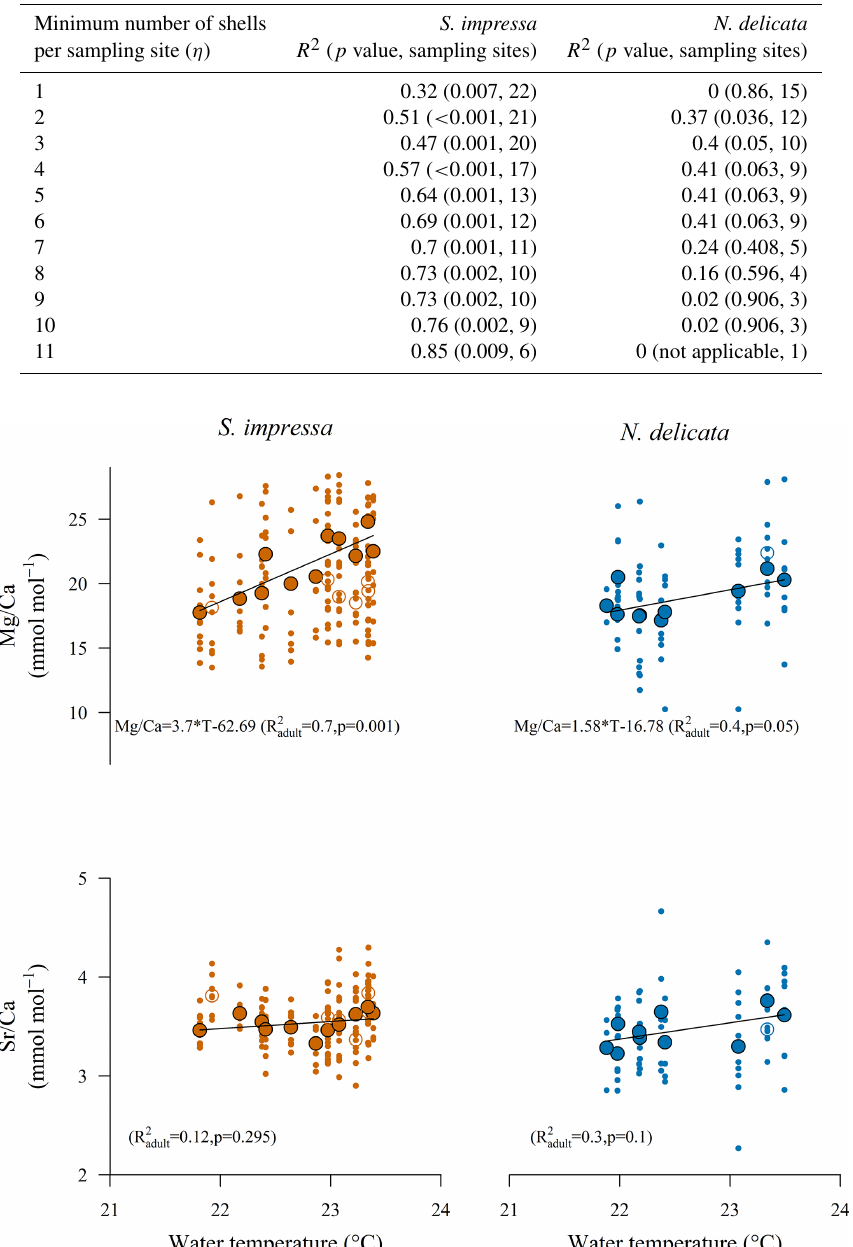
Table 3. Correlation fit and significance of temperature calibrations using different number of shells per sampling site to calculate the mean value of ostracod Mg / Ca ratios for S. impressa and N. delicata .